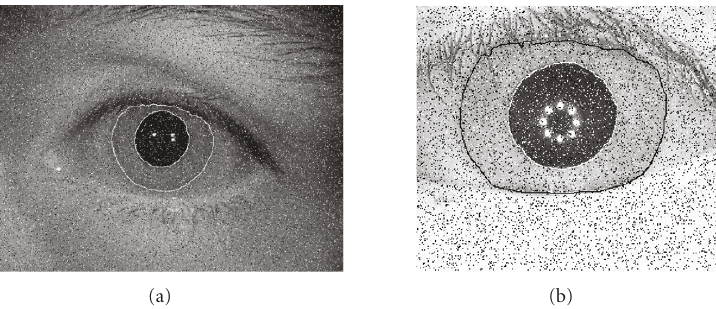
Figure 11: Performance of the proposed algorithm to iris images with (a) 10 percent and (b) 15 percent of salt and pepper